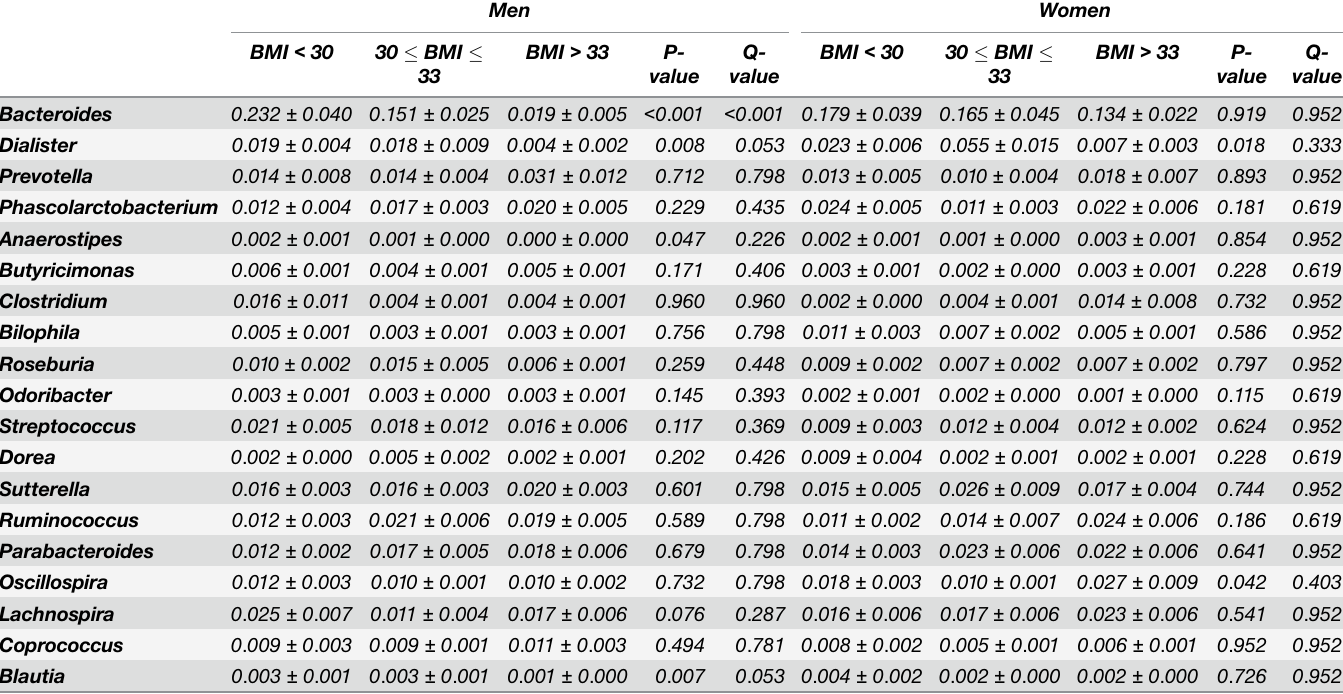
Table 1. Gender differences in the gut microbiota by BMI at genus level.